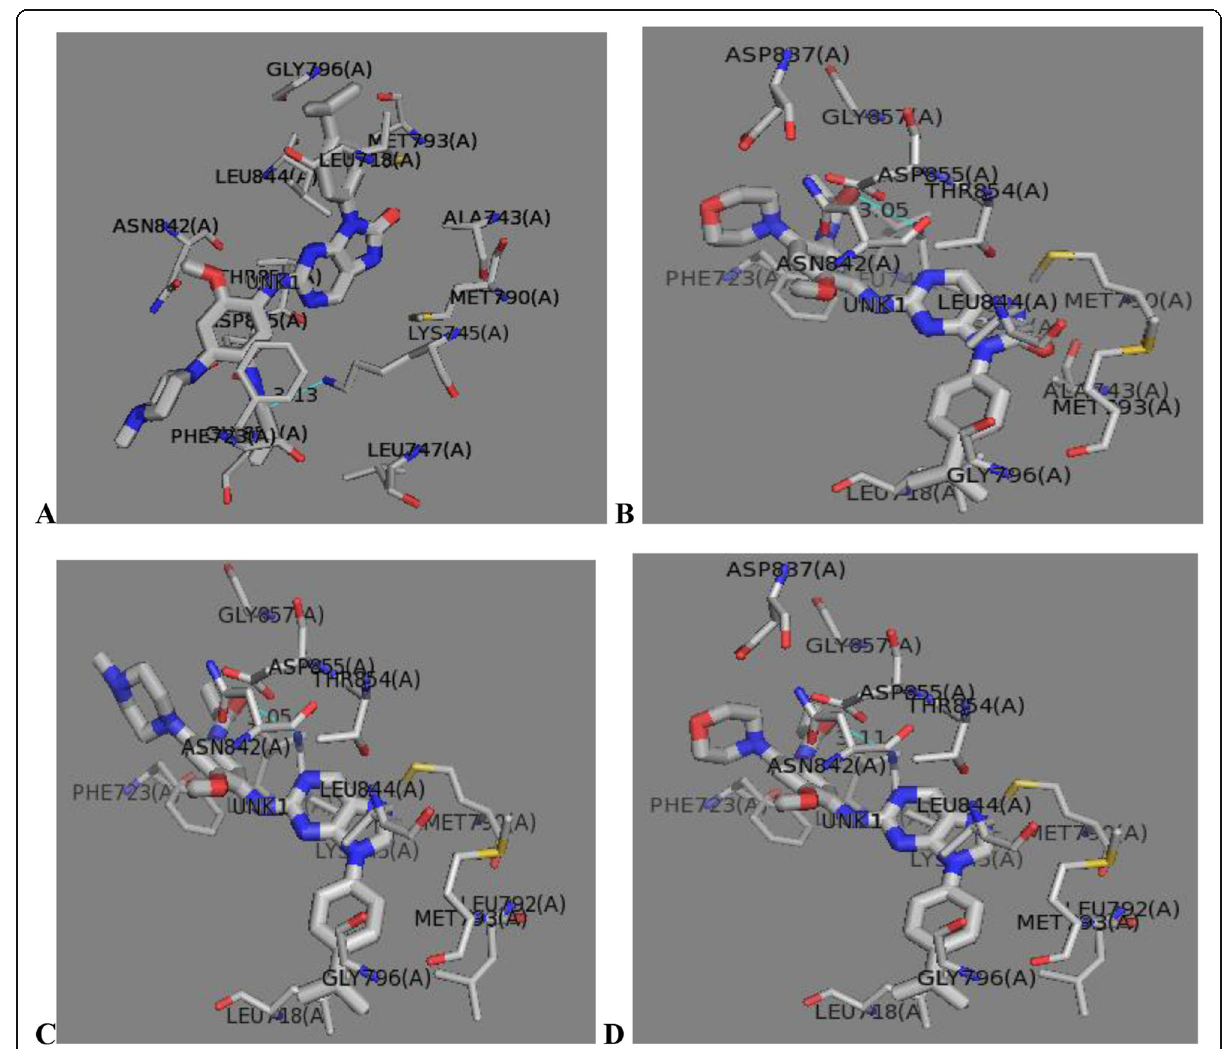
Fig. 4 2D and 3D structures of ( a ) Complex 22, ( b ) Complex 24, ( c ) Complex 17, and ( d ) Complex 19 using